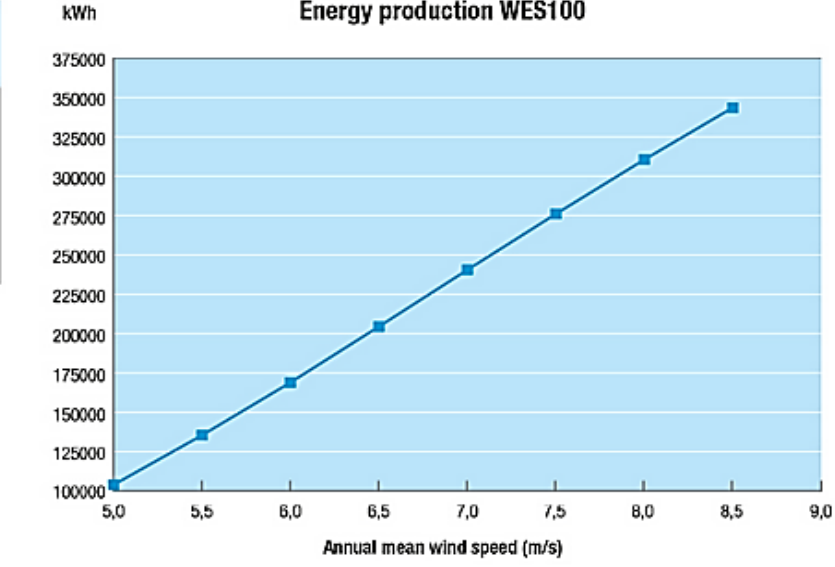
Figure 7. Annual energy generation in Kwh. Source: http://www.energiapura.com/ aerogerador-wes-100.